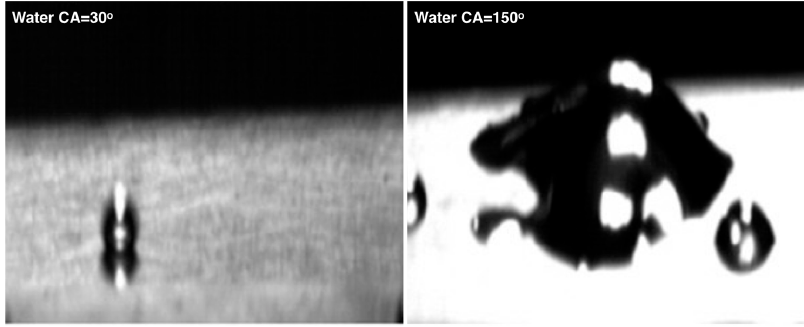
Figure 19. Experimental images of pool boiling of water on hydrophilic and hydrophobic surfaces [56].